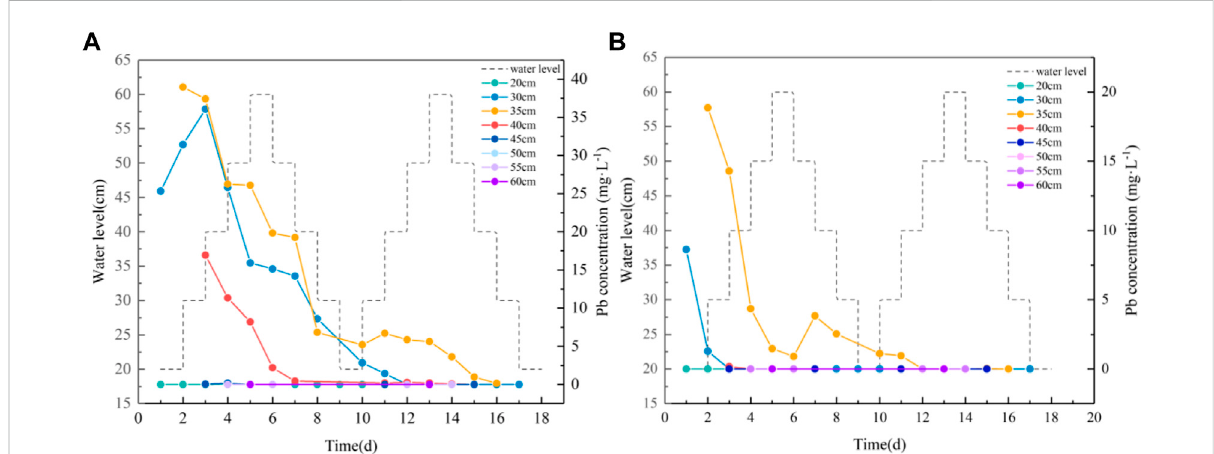
FIGURE 3 Relation diagram between the Pb content and water level fl uctuation. (A) : Variation of Pb concentration in water of coarse sand column; (B) : variation of Pb concentration in water of medium sand